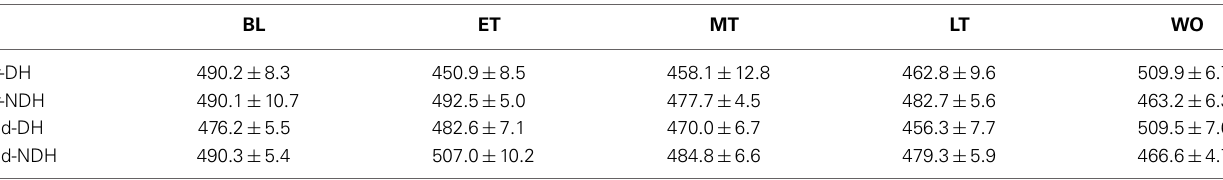
Table 2 | Peak movement velocity (mm/s) from the baseline block (BL), early training block (ET), middle training block (MT), late training block (LT), and the washout block (WO).